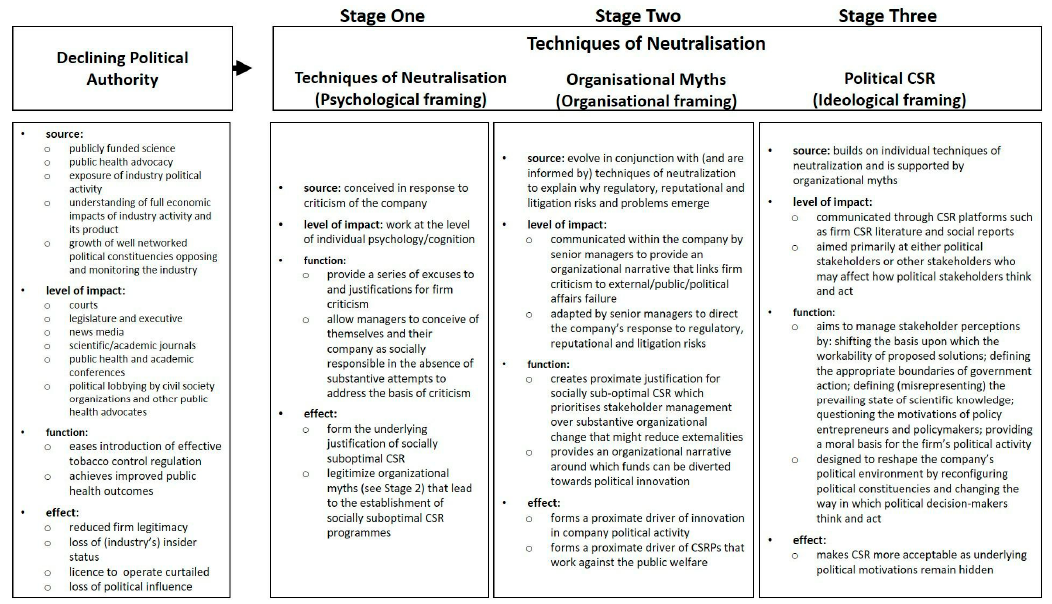
Figure 4. Techniques of neutralisation as they apply to corporate actors. Source: Adapted from [17].